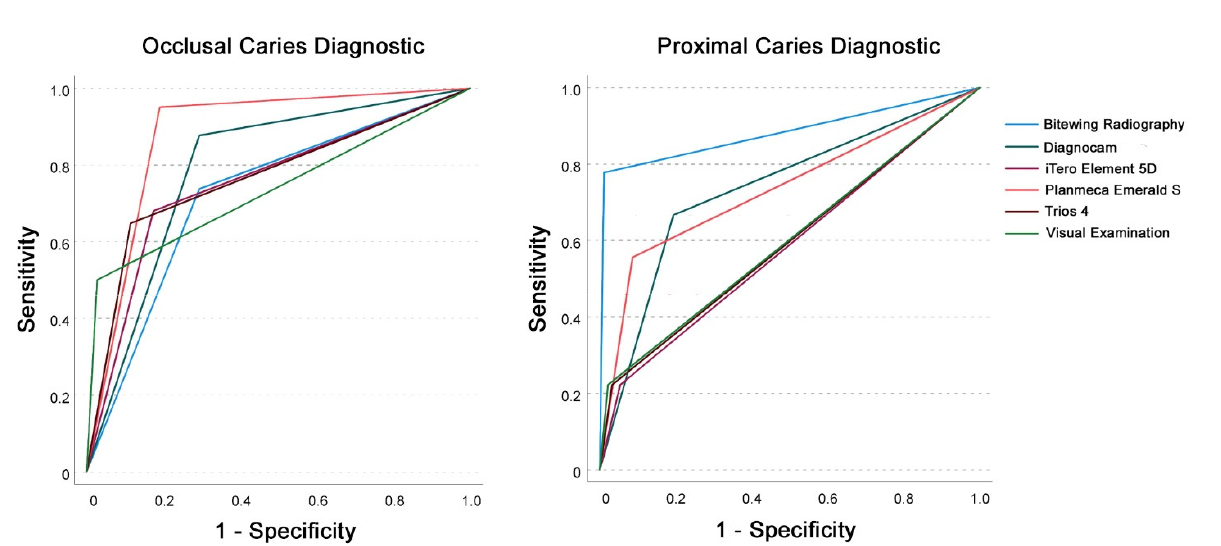
Figure 6. Receiver operating characteristic (ROC) curve analysis for occlusal ( left ) and proximal ( right ) caries diagnostics for the investigated diagnostic methods in permanent teeth with threshold II (sound/enamel caries versus dentin caries).